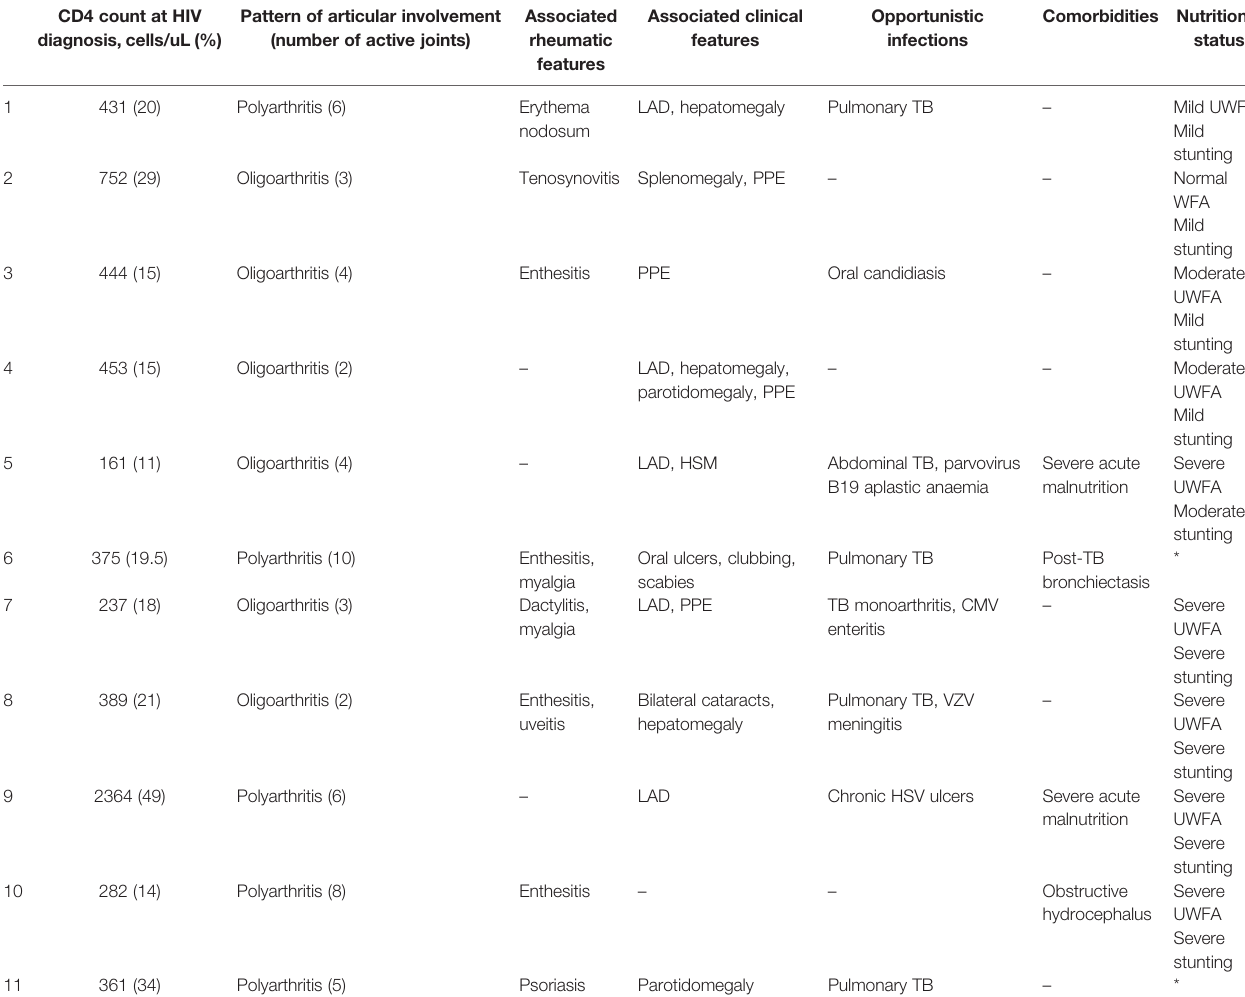
TABLE 1 | Clinical presentation. CD4 count at HIV Pattern of articular involvement diagnosis, cells/uL (%) (number of active